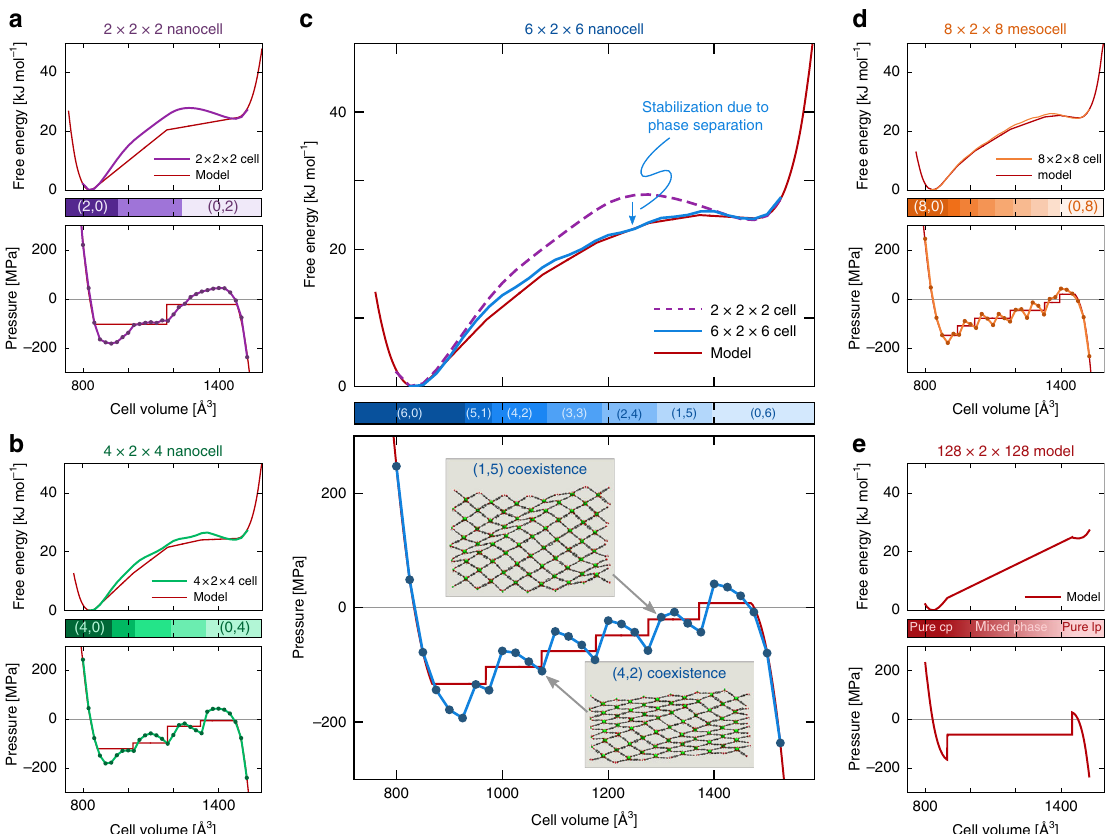
Fig. 3 Stabilization of the metastable cp/lp coexistence regions with increasing cell size. Pressure (bottom) and free energy (top) equations of state, with indication of the metastable ( n , n ) phase coexistence regions, in which n cp and n lp layers coexist, as a function of the volume (middle) for four cp lp cp lp different cell sizes: a a 2 × 2 × 2 supercell, b a 4 × 2 × 4 supercell, c a 6 × 2 × 6 supercell, and d an 8 × 2 × 8 supercell, all at 300 K. The red lines indicate the fi tted thermodynamic model, which is extrapolated in e for a 128 × 2 × 128 cell (208.0 × 1.4 × 171.2 nm 3 ), similar in size to experimental MIL-53(Al)-NH crystals (see Supplementary Note pressure, and chemical potential under which a material becomes fl exible (see Methods section) 21 . For a given material, its different